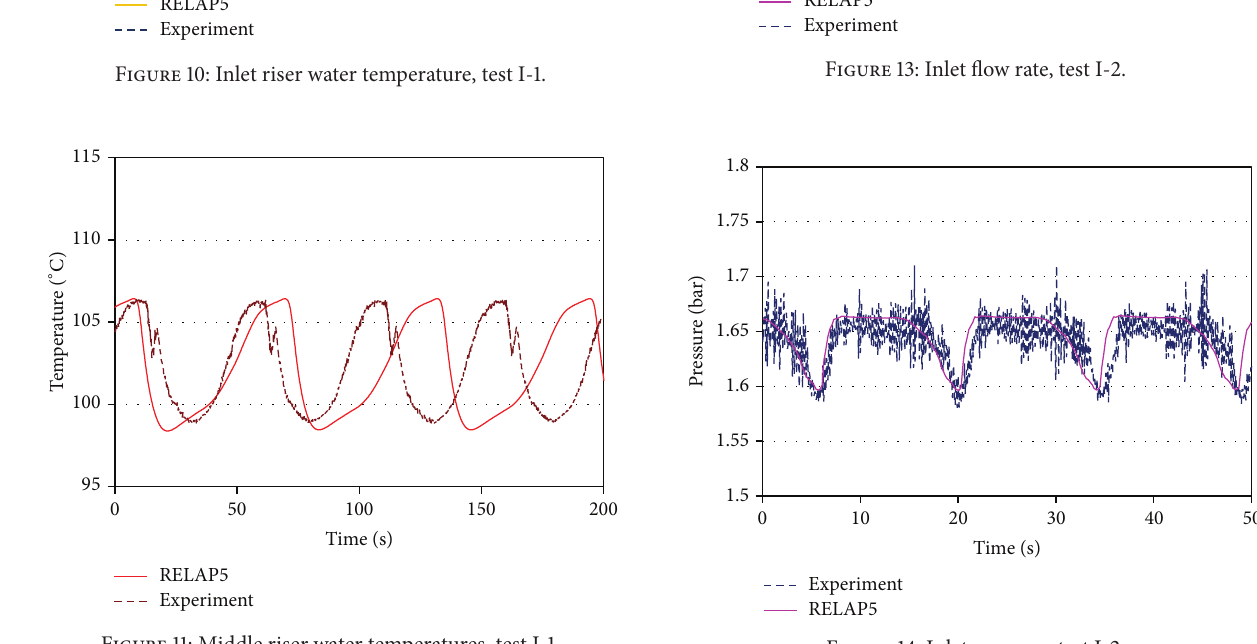
Figure 14: Inlet pressure, test I-2.